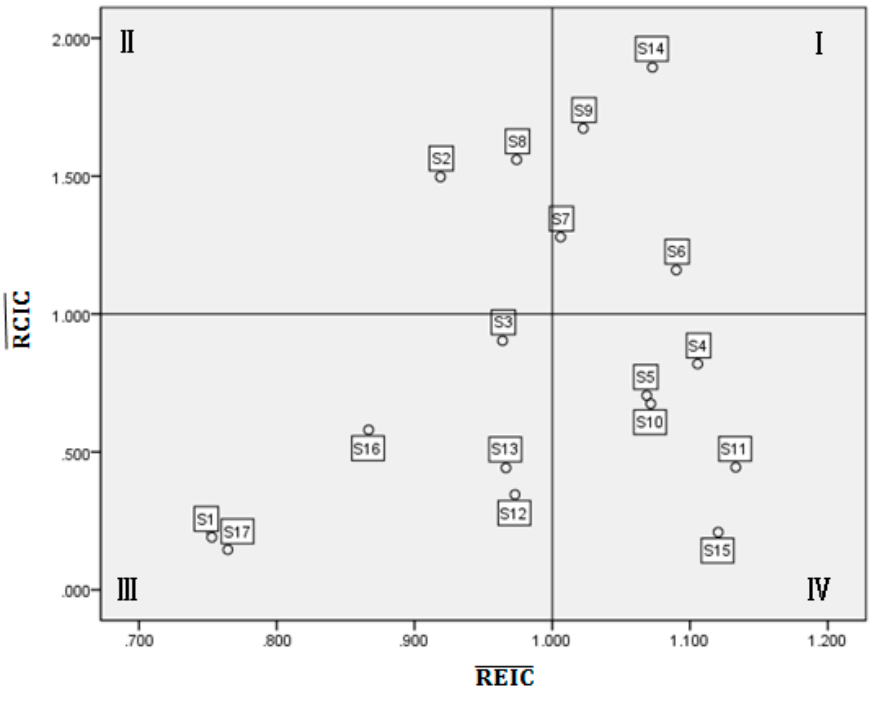
Figure 1. Matrix of the (cid:1844)(cid:1831)(cid:1835)(cid:1829)(cid:3364)(cid:3364)(cid:3364)(cid:3364)(cid:3364)(cid:3364)(cid:3364) and (cid:1844)(cid:1829)(cid:1835)(cid:1829)(cid:3364)(cid:3364)(cid:3364)(cid:3364)(cid:3364)(cid:3364)(cid:3364) of China’s 17 sectors in 2010.